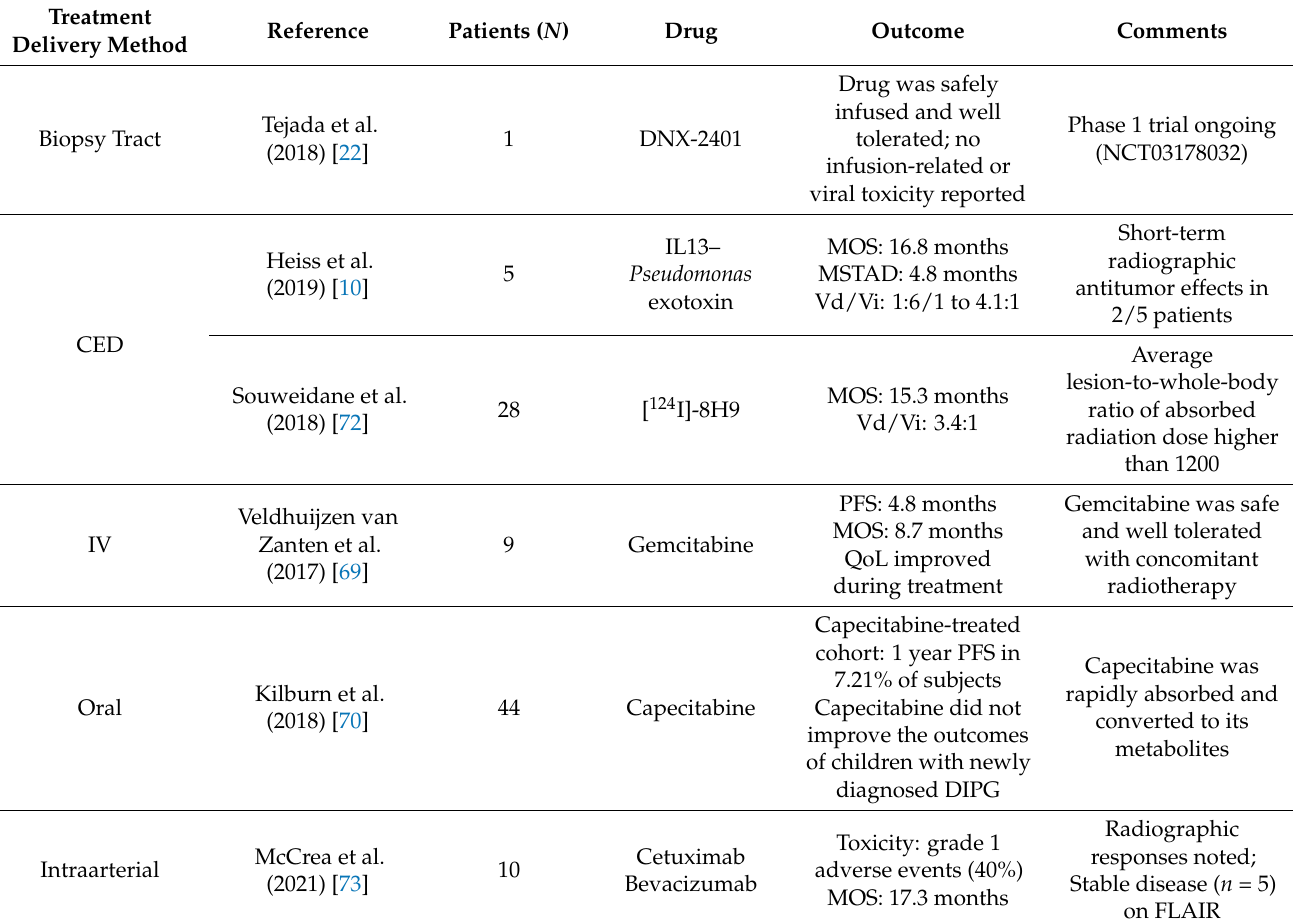
Table 2. Drug delivery for H3K27M-mutant diffuse midline glioma. Recent drug delivery studies and trials for the treatment of H3K27M-mutant diffuse midline